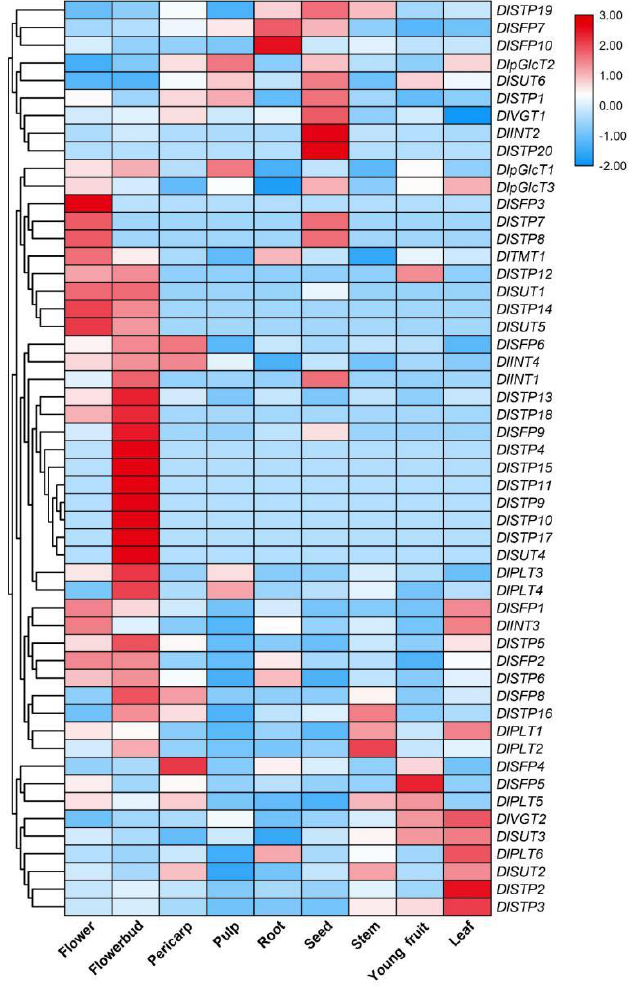
Figure 8. Expression profiles of the DlSTs in different tissues. The color scale represents the log2 (expression values + 1); the red and blue colors indicate the higher or lower expression level, respectively.